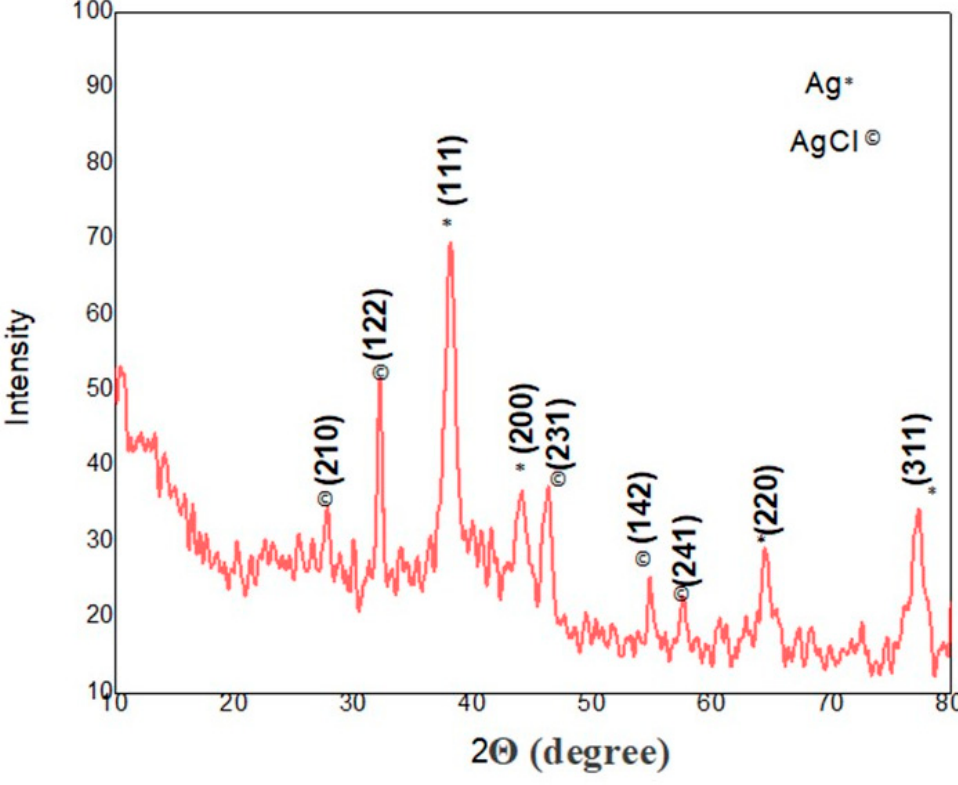
Figure 5. XRD analysis showing crystalline planes for the synthesized silver/silver chloride nano- particles.